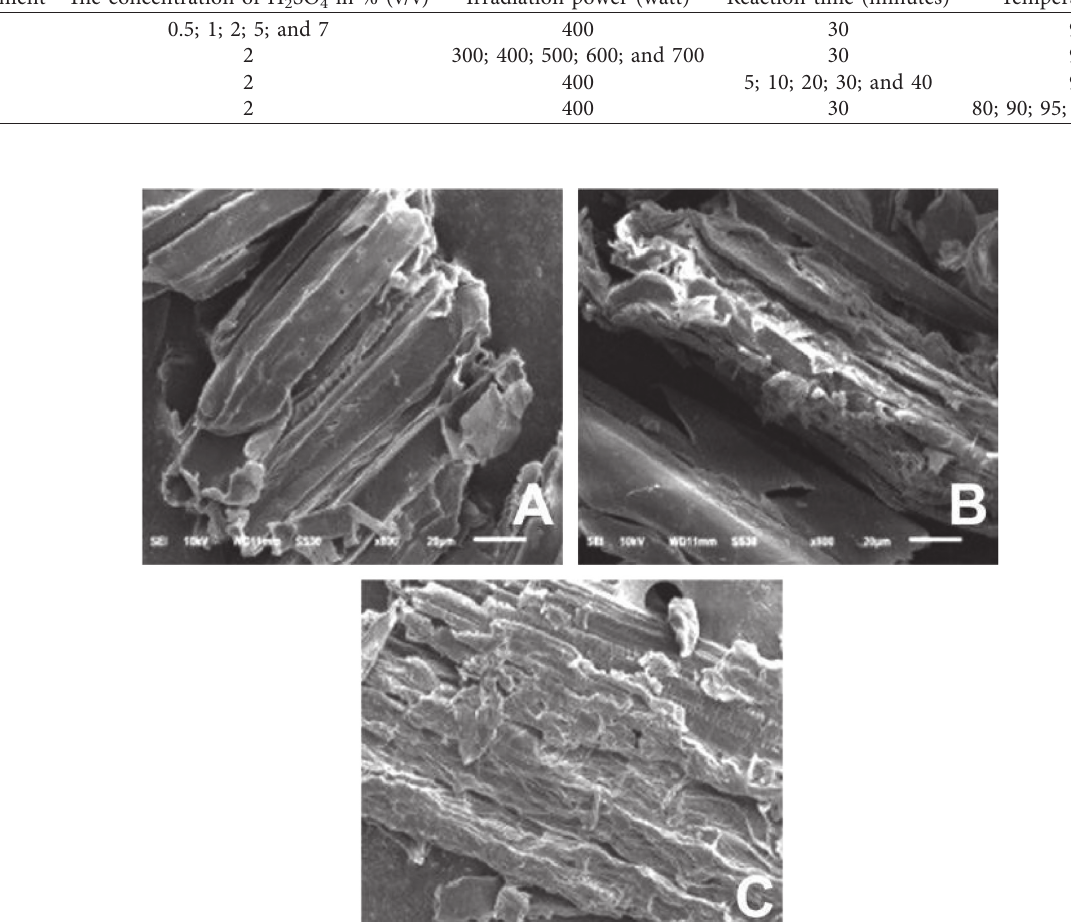
Table 1: The optimization conditions of the microwave-assisted hydrolysis of delignified elephant grass powder with acid catalyst using the SINEO MAS II microwave reactor. Treatment The concentration of H 2 SO 4 in % (v/v)